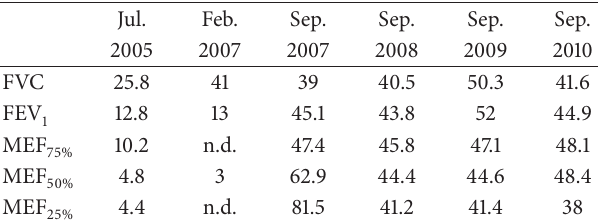
Table 1: Details of pulmonary function testing between 2005 and 2010 (numbers are given in percent of the predicted value).